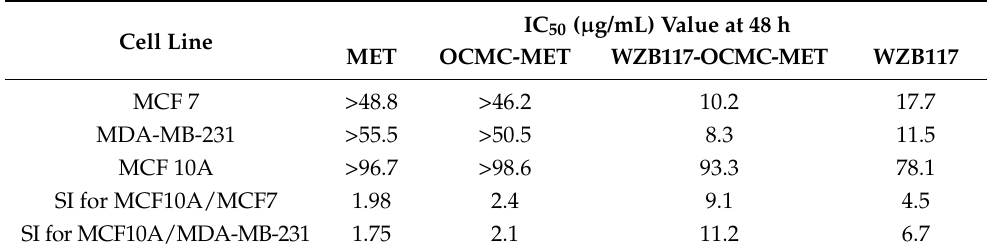
Table 1. IC 50 value and selectivity index of MET, OCMC-MET, WZB117-OCMC-MET, and WZB117 on MCF7, MDA-MB-231, and MCF10A cell